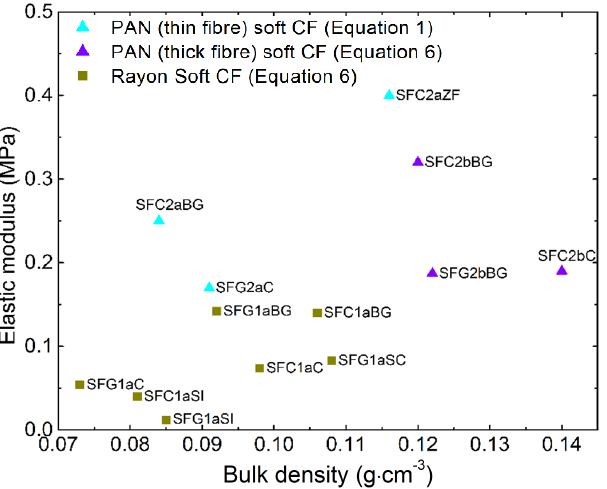
Figure 7. Values of elastic modulus calculated either by Equation (1) for soft CFs derived from PAN (thin fibers) or by Equation (6) for soft CFs derived from Rayon and from PAN (thick fibers), as a function of bulk density. The symbols have the same meaning as in Figure 3.